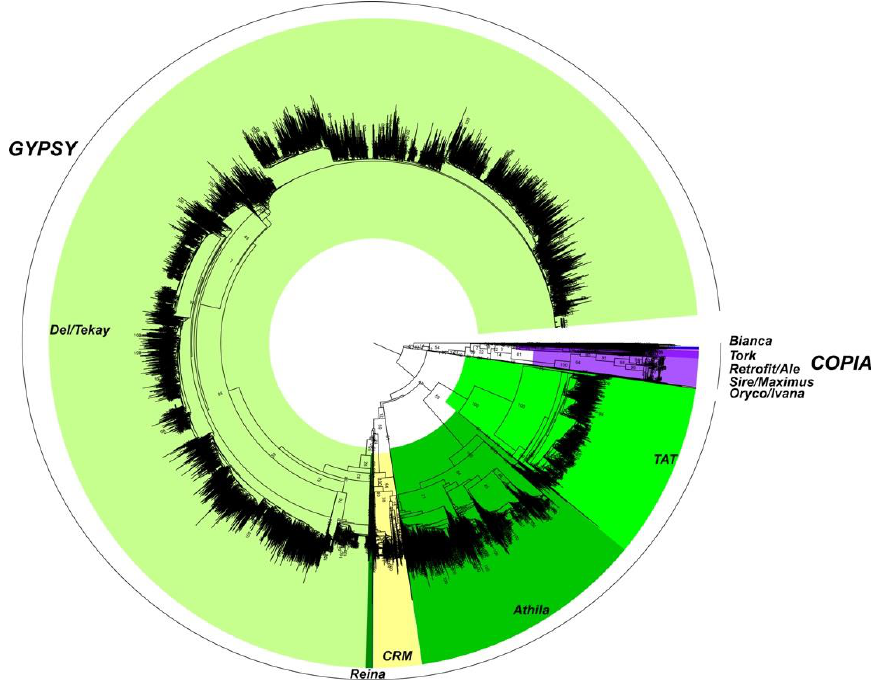
Figure 3. Quantitative representation, on a genome scale, of LTR retrotransposon RT domains in the H. brasiliensis PB 260genomic sequences. The phylogenetic analysis was carried out with reverse transcriptase (RT) domains (19,151) having a length > 200 aa and amino-acid identity > 70% compared to the RT reference domains downloaded from GyDB. The Gypsy LTR retrotransposon clades are represented in di ff erent green and yellow colours. The Copia LTR retrotransposon clades are represented in